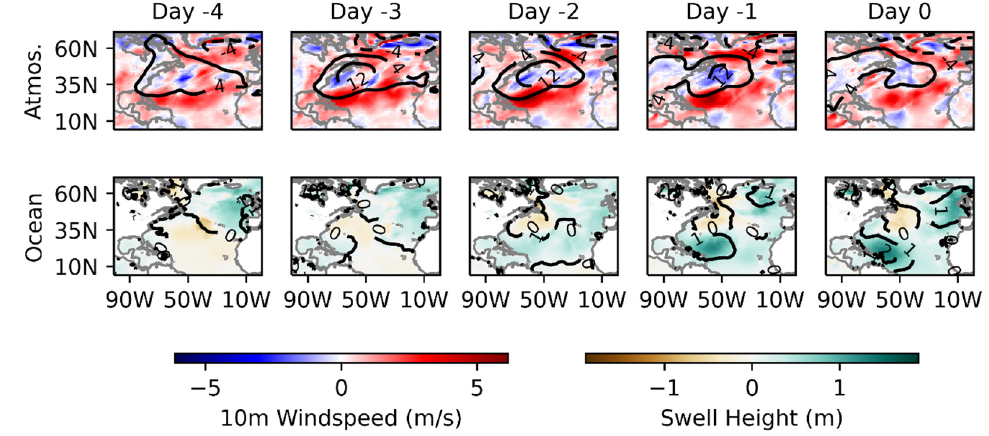
Figure 14. Same as Figure 10 except anomaly composites for high pressure induced, medium probability north swell events (10 days composited per map). Day 0 is the day that was classified as a north swell day.